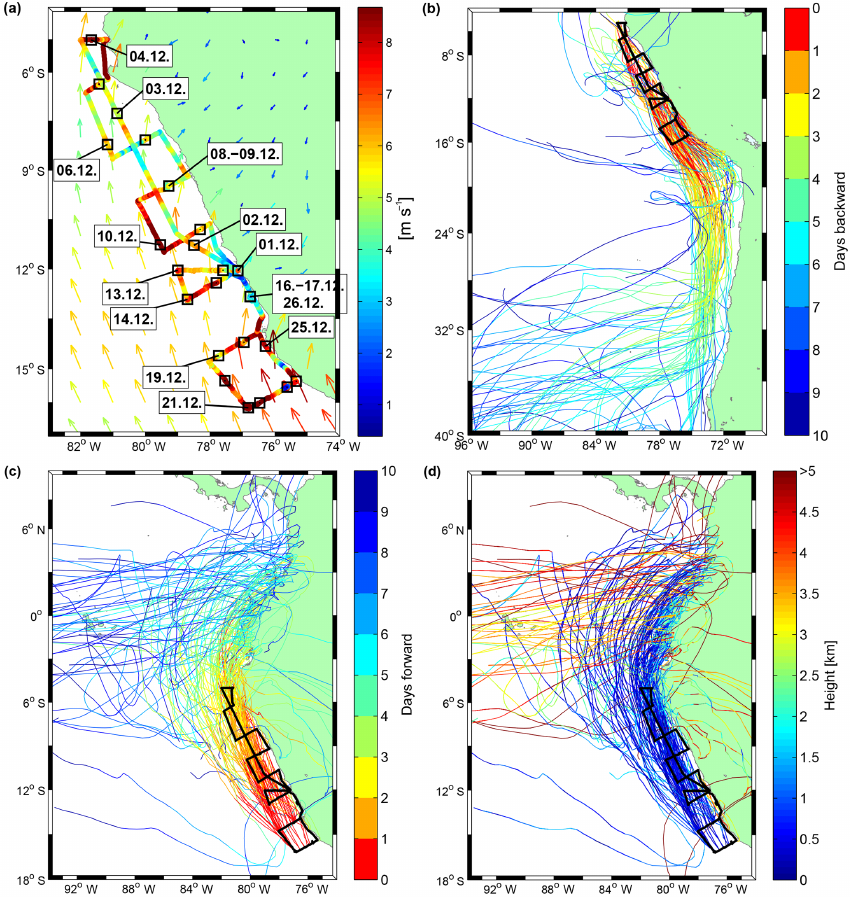
Figure 1. (a) 10min mean of wind speed observed on R/V METEOR displayed along the cruise track; monthly mean (December 2012) of 10m wind speed and direction from ERA-Interim displayed as arrows. (b) Extract from 10-day FLEXPART back-trajectories coloured according to the time until they reach the specific ship position on the cruise track of R/V METEOR (black). (c) Extract from 10-day FLEXPART forward trajectories coloured according to the time since they were released. (d) Same as (c) but coloured according to the height (km) of the